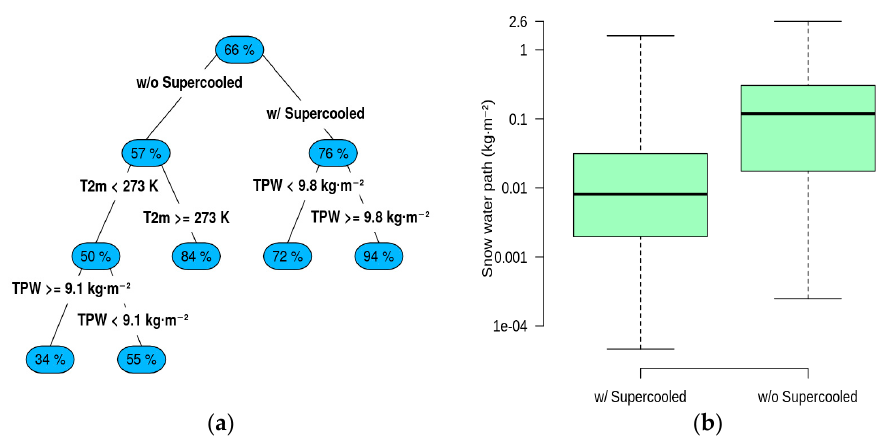
Figure 6. ( a ) Decision tree, with the absolute value of the normalized difference percentage between predicted and observed SWP indicated in boxes, and partitioning variables and thresholds indicated on branches; and ( b ) Boxplot of observed SWP, with supercooled droplets (left) and without supercooled droplets